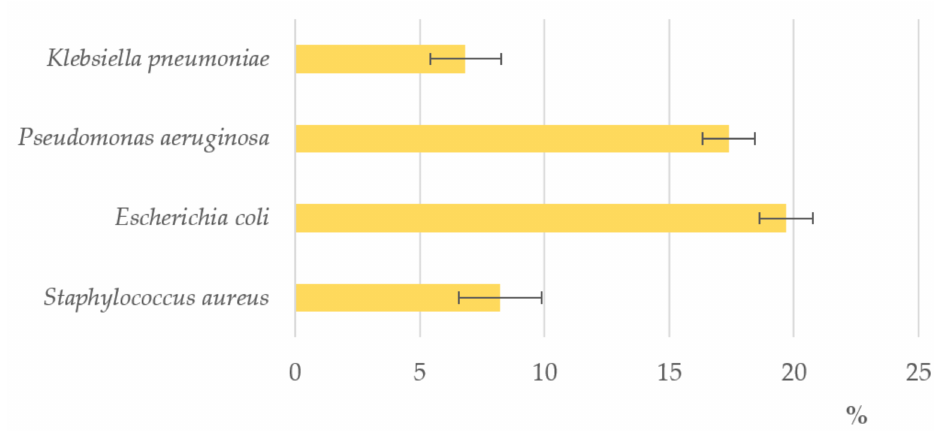
Figure 8. MIC—Minimum Inhibitory Concentration (% v / v ) of strawberry tree ( Arbutus unedo L.) honey (STH) from Sardinia (bitter honey) against different bacterial cultures